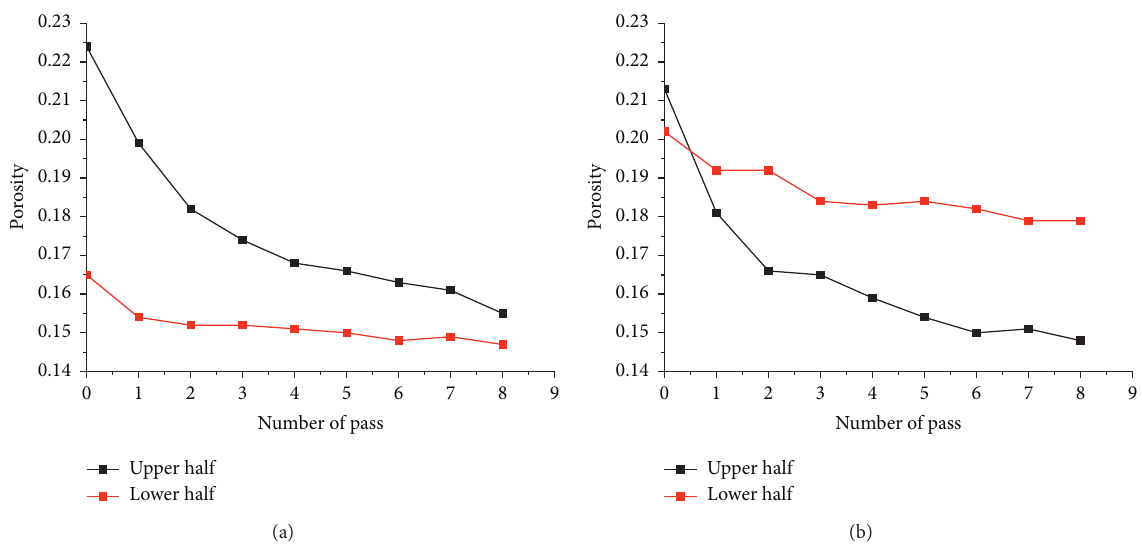
Figure 21: Porosity evolution of the upper and lower half of the rockfill model during compaction. (a) Case B. (b) Case